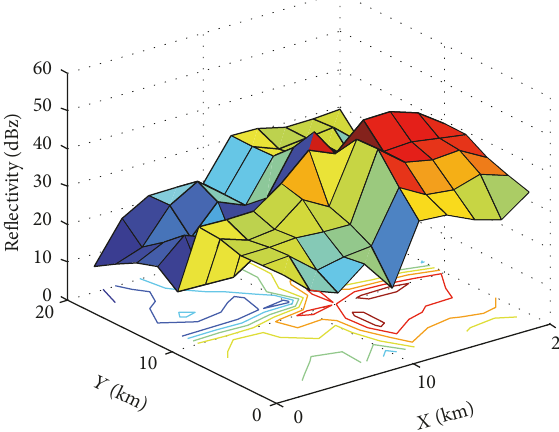
Figure 7: Observation field of radar reflectivity